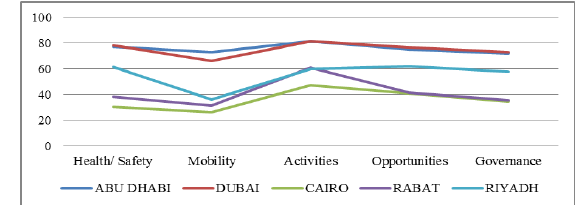
Figure 3: UN HDI